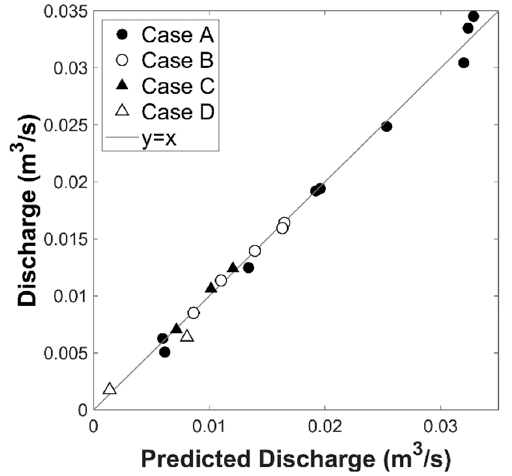
Figure 7. Relationship between discharge and the model presented in Equation (4) and Table 4.